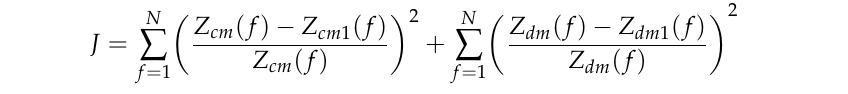
Figure 4. Flow chart of particle swarm